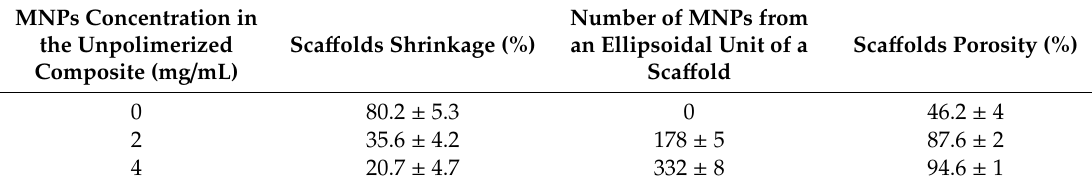
Table 1. Sca ff olds shrinkage, number of MNPs from an ellipsoidal unit of a sca ff old as determined from enhanced dark field microscopy images using the dedicated plug-ins for nanoparticles counting and sca ff olds porosity determined as in